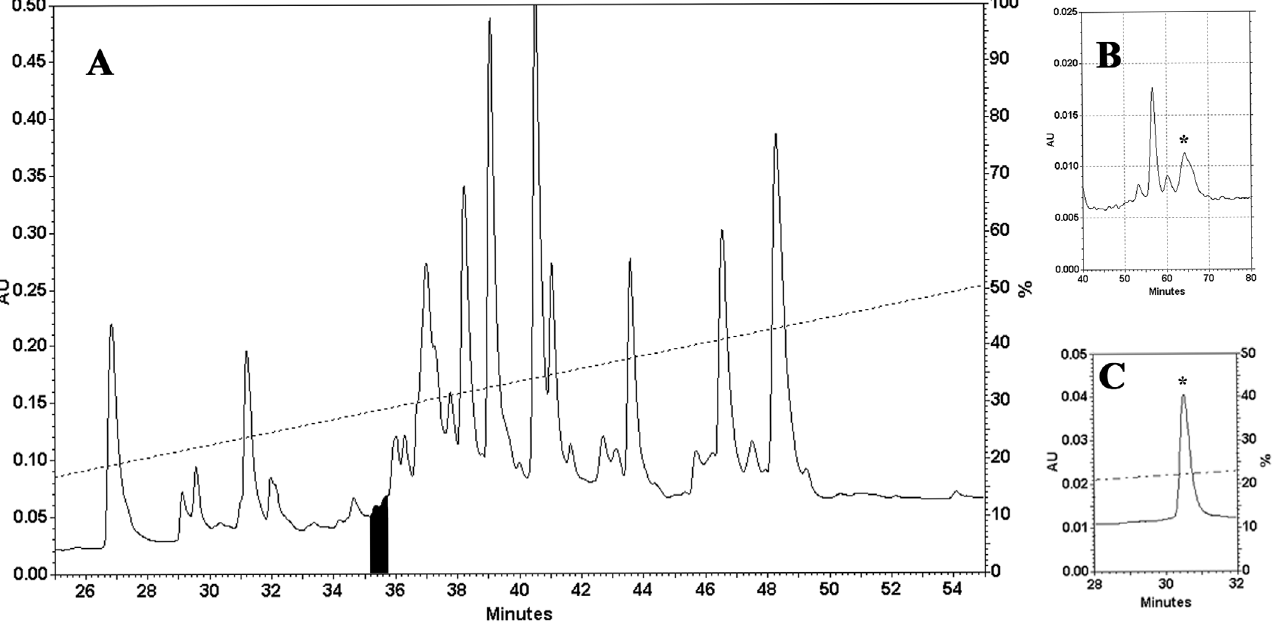
Figure 1. Isolation of novel peptide from C. bandanus venom. (A) RP-HPLC profile of C. bandanus venom. (B) Separation of the fraction highlighted in black. (C) Homogeneity inspection of the asterisk